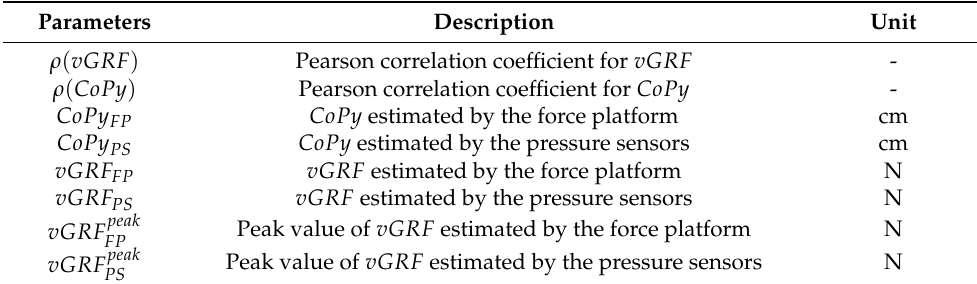
Table 2. Summary of the variables and parameters used in the analysis. Parameters Description Unit Pearson correlation coefficient for vGRF - Pearson correlation coefficient for CoPy - CoPy FP CoPy estimated by the force platform cm CoPy PS CoPy estimated by the pressure sensors cm vGRF estimated by the force platform